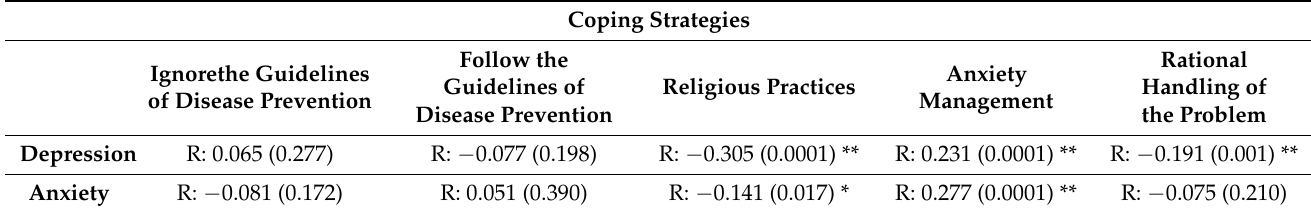
Table 5. Correlation between depression or anxiety and coping strategies in the Egyptian population. Pearson correla- tions were performed to correlate coping strategies to the occurrence of depression or anxiety. Asterisk (*) indicates a significant correlation ( p < 0.05), whereas (**) indicate significant correlation ( p <